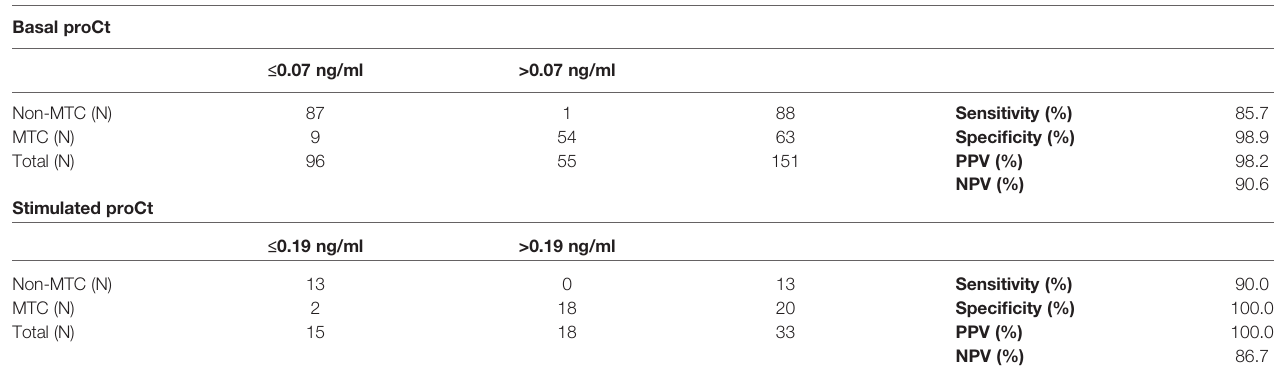
TABLE 5 | Basal procalcitonin (proCt) and stimulated proCt accuracies in the identi fi cation of medullary thyroid cancer (MTC) patients in our series. Basal proCt ≤ 0.07